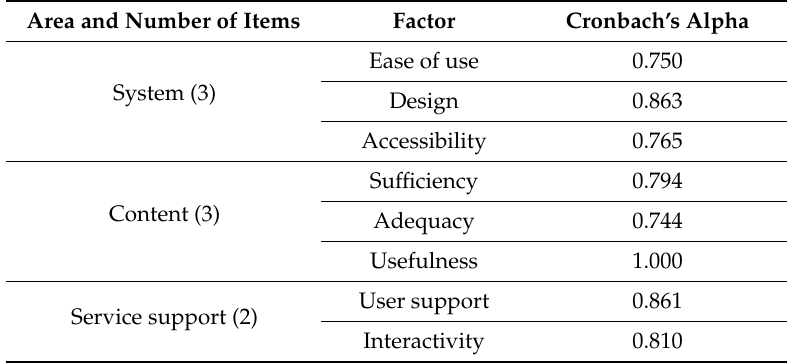
Table 2. Internal consistency reliability analysis of the independent